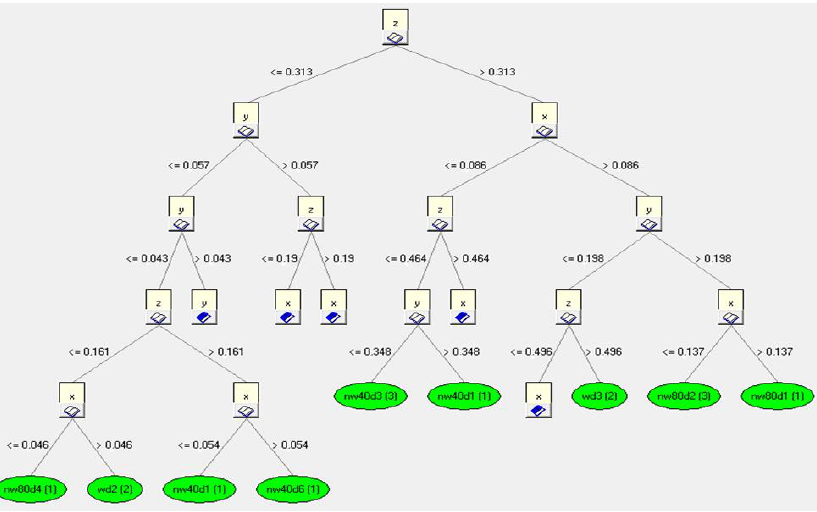
Figure 20. Data classification for x , y and z components at 50 km/h.